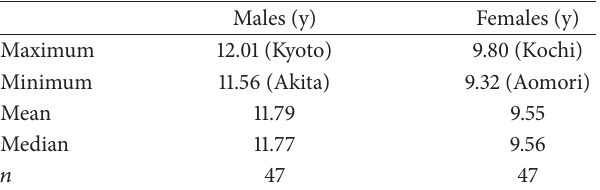
Table 2: Basic statistics of age at